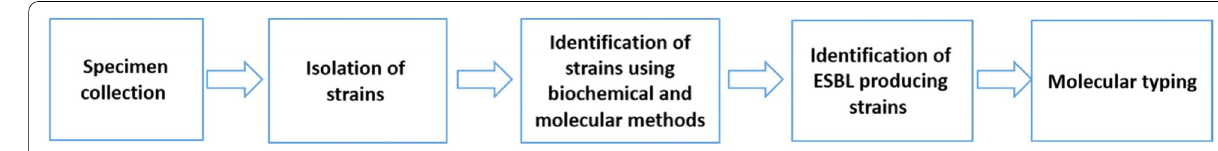
Fig. 1 A flowchart of method